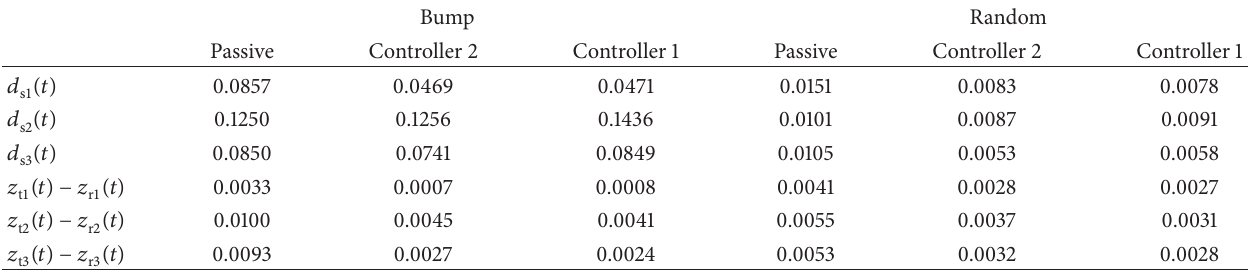
Table 4: Comparison of peak values of landing gear suspension stroke and tire deflection responses for both controlled and uncontrolled